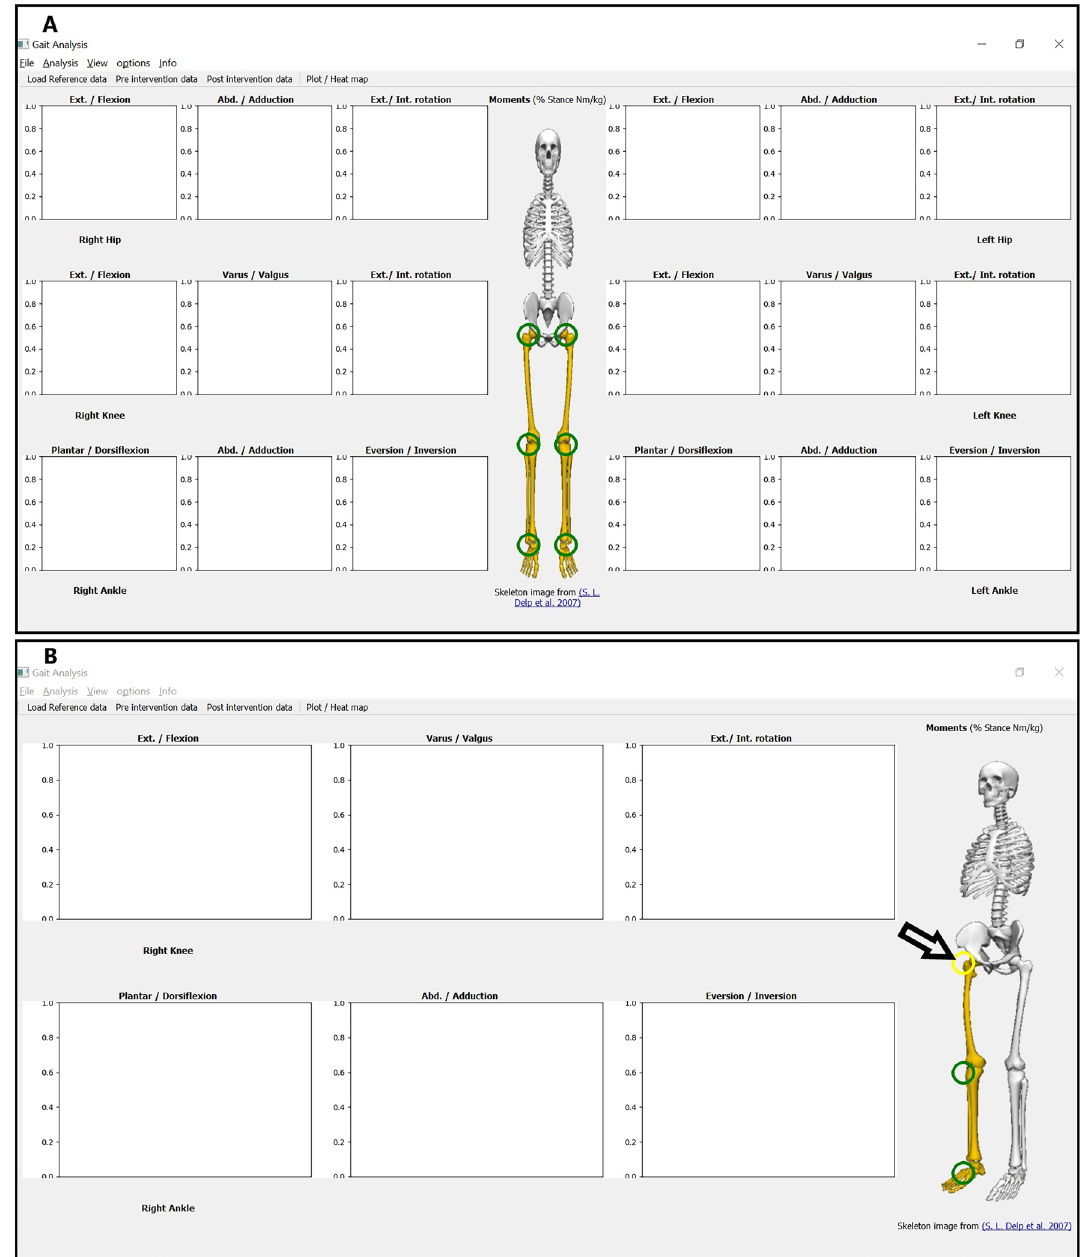
Figure 1. Initial MovementRx main window. ( A ) Main window at start up. ( B ) Focused view on 2 joints (right knee and ankle) only, hiding the whole left side and right hip. The skeleton image is used as an approximate visual reference, to emphasize the currently visualized o Paired The 3D vector is compared using Hotelling paired test, while the individual components are compared using paired T test. o Two Sample The 3D vector is compared using Hotelling’s 2 test, while the individual components are compared using T test 2. After selecting the analysis method, a combined colormap representing the combined severity of the abnor- malities vector in all three dimensions appears below every joint in the view panel. Figure 3 shows a screenshot of MovementRx after applying pre and post intervention vs reference. The legend present in the right side of Fig. 3 can be shown, hidden, or undocked to float as a separate window. The severity of the deviation of the case from the reference normal is color-coded from blue (subtle/mild) to dark red (extreme/very severe), scaling from 1 to 4 folds in case of individual components (left) and from 1 to 8 folds